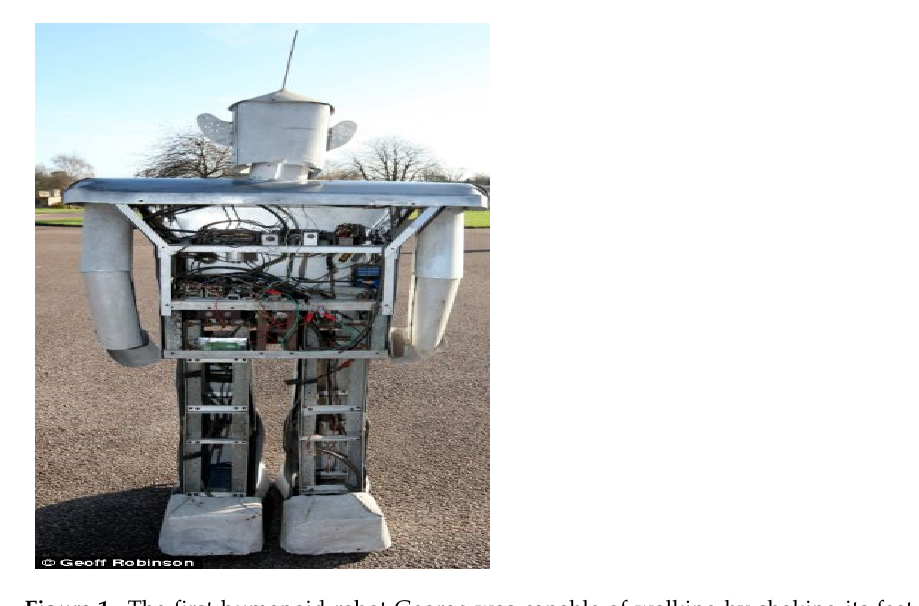
Figure 1. The first humanoid robot George was capable of walking by shaking its feet and was remote-controlled [6].